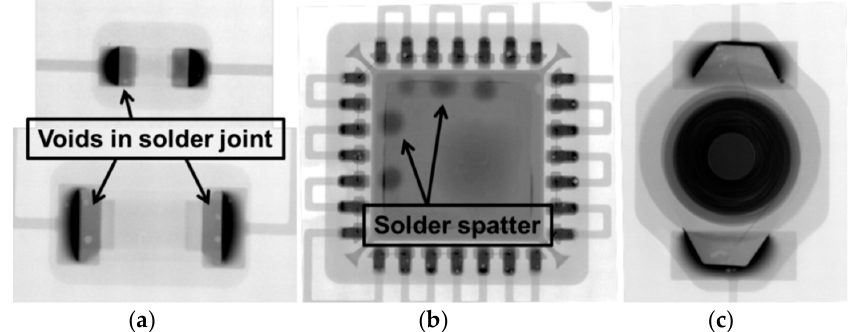
Figure 15. X-ray images of encapsulated devices (MT03): ( a ) resistors: voids in solder joint visible with no defect in the encapsulation; ( b ) MLF28: voids in solder joint, solder spatter and remnants of solder paste visible, and void in encapsulation in the gap under the device is possible; and ( c ) induction coil: voids in solder joint visible with no defect in encapsulation.